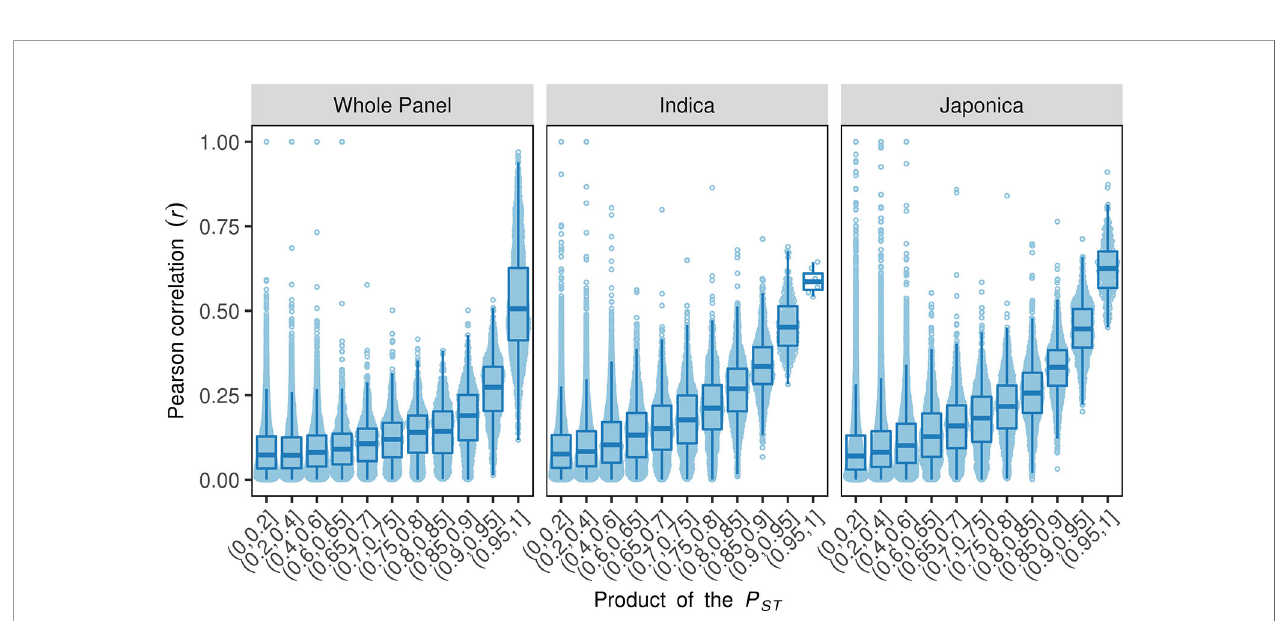
FIGURE 5 | The relationships between the products of the two phenotypes' phenotypic divergence ( P ST ) and their correlation in the whole panel and two rice subspecies. The x-axes show the intervals of the product of the two phenotypes' P ST , the y-axes indicate the absolute value of the Pearson correlation coef fi cients between the two